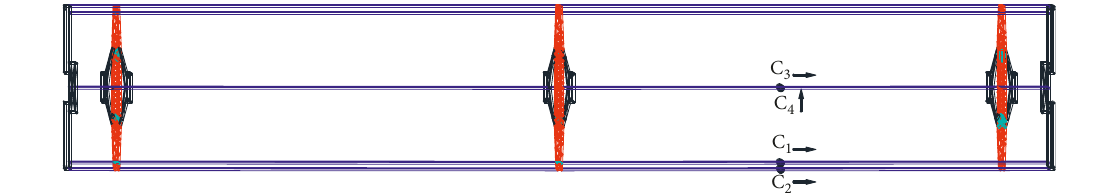
Figure 18: Layout of the acceleration sensors on the five-tower-four-line model.